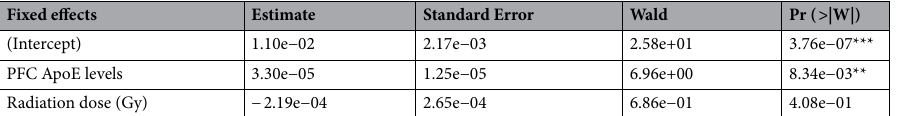
Table 8. Linear generalized estimating equations model results predicting relative hippocampal volumes with ApoE levels in the PFC and radiation dose as independent predictors. *** p < 0.001, ** p < 0.01; displayed p -values are uncorrected for multiple